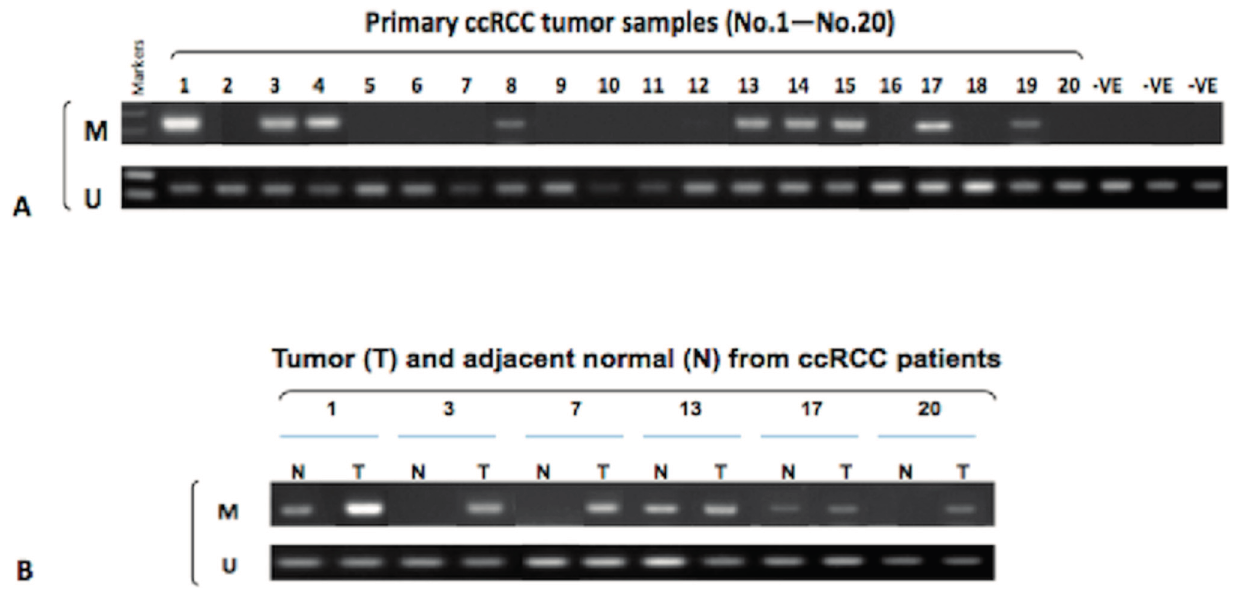
Figure 3. Representative MSP results. ( A ) ADAMTS18 gene hypermethylation was